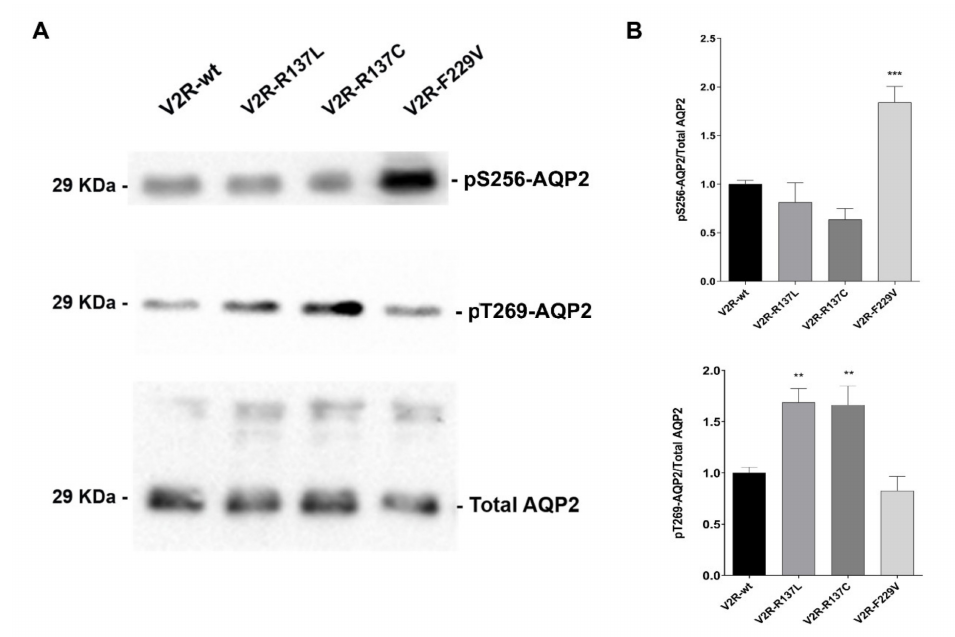
Figure 1. V2R Cells expressing R137L and R137C have significantly higher basal levels of p269-AQP2. ( A ). Representative western blots of MCD4 lysates showing phosphorylation of AQP2 at Ser-256 (pS256-AQP2) or Thr-269 (pT269-AQP2) in cells expressing the wild-type V2R or the constitutively active R137L, R137C and F229V under basal conditions. For normalization, cell lysates were also probed for total AQP2 (Total AQP2). ( B ). Densitometric analysis of pS256-AQP2 and pT269-AQP2 bands normalized to total AQP2 bands (Total AQP2) is reported in the histograms. The data are means ( ± S.E.M.) of 5 experiments (** p < 0.01 or *** p < 0.001 vs.